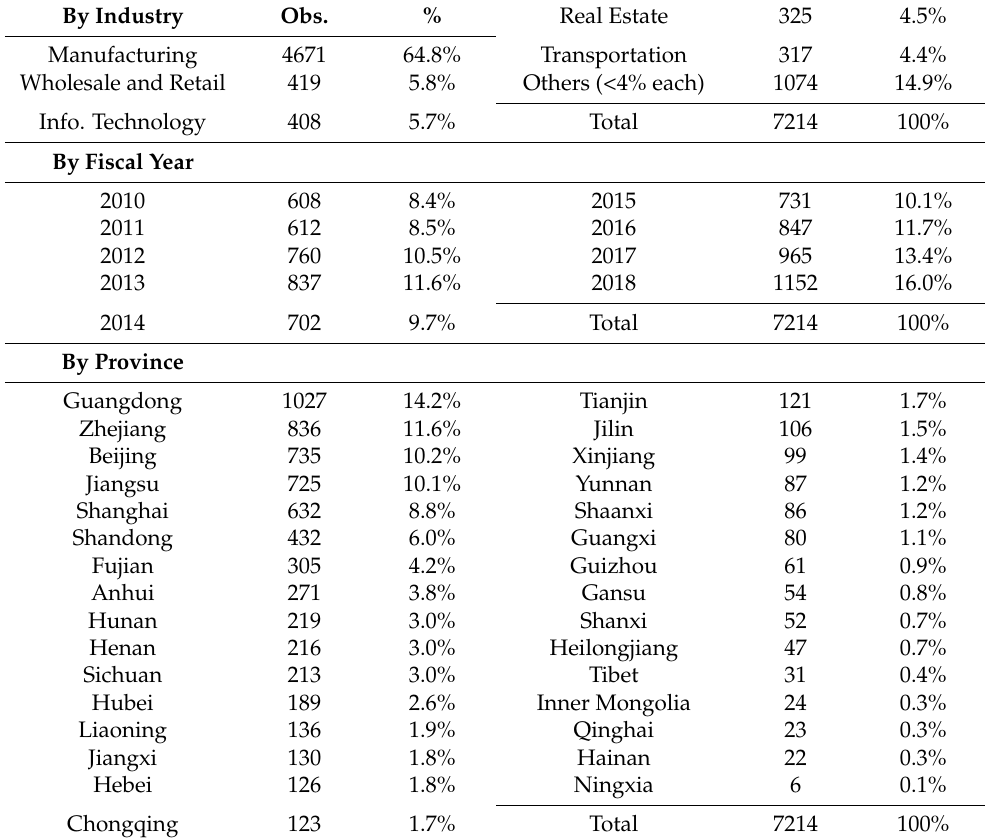
Table A1. Sample Distribution by Industry, Year, and